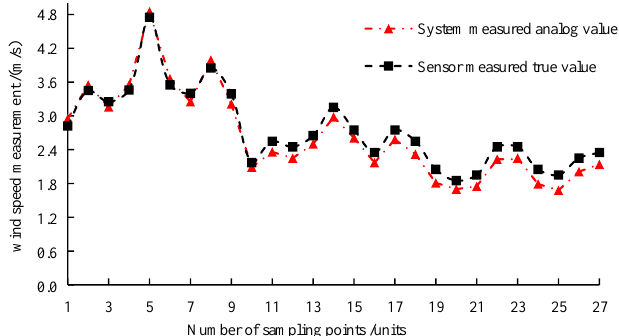
Figure 11. Comparison of wind speed measurement between system analog and sensor measured value at sampling points .